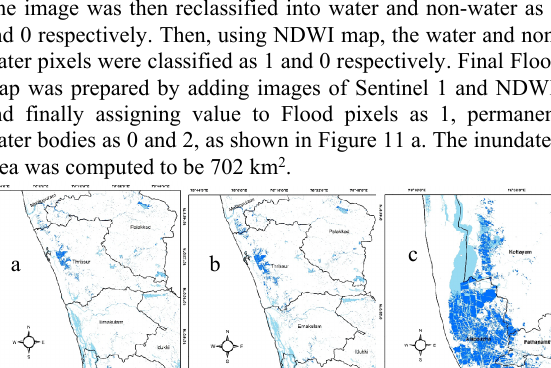
Figure 10. Daily flow obtained from HEC-HMS for outlets and major dams of Muvattupuzha basin Table 3: Dams in Muvattupuzha basin and their characteristics